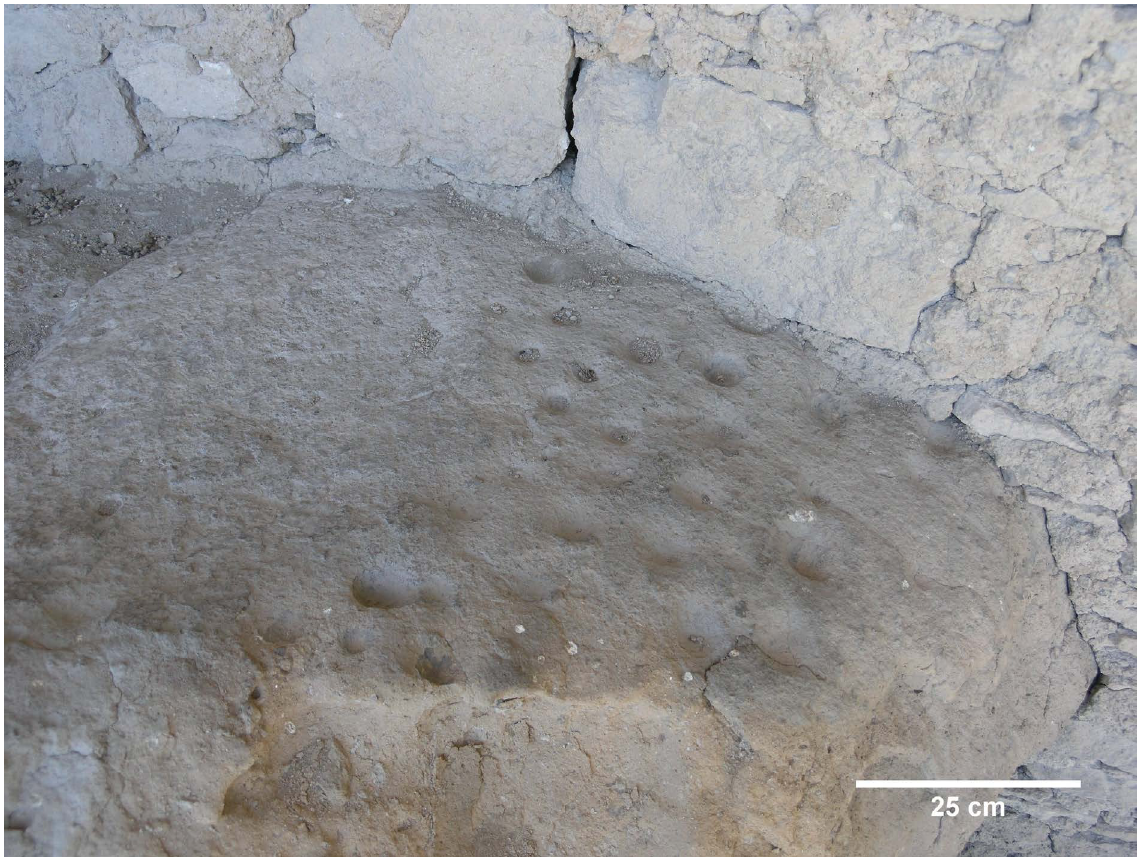
Figure 3. RMP-5 at Gila Cliff Dwellings National Monument with cupule depressions. Scale is